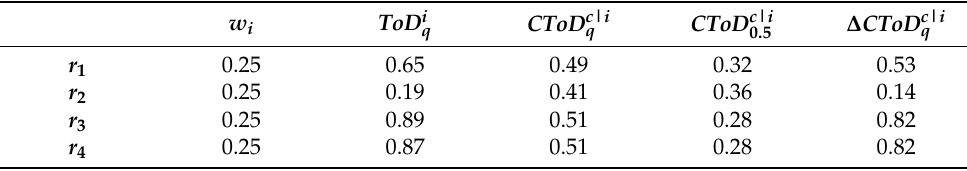
Table 3. Conditional Threshold of